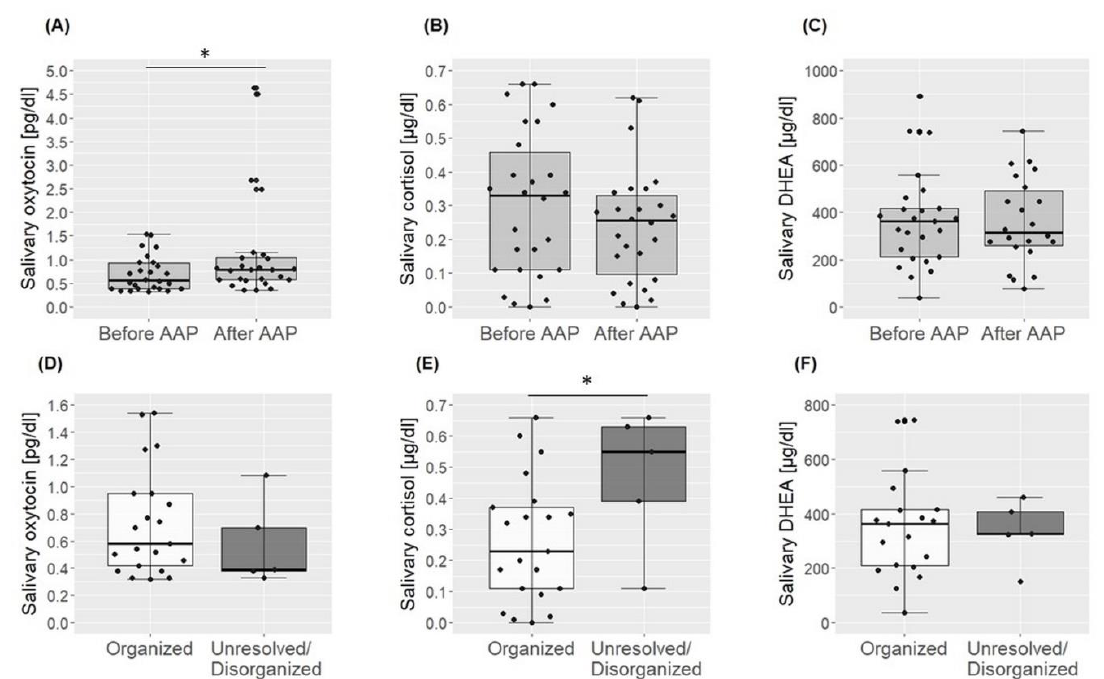
Figure 2. Graphical representation of results from the analysis of oxytocin, cortisol and DHEA before and after the AAP for the total cohort in light grey boxes ( A – C ) and before the AAP between fathers with an organized (white boxes) an unresolved/disorganized (dark grey boxes) AR ( D – F ). * p < 0.05.